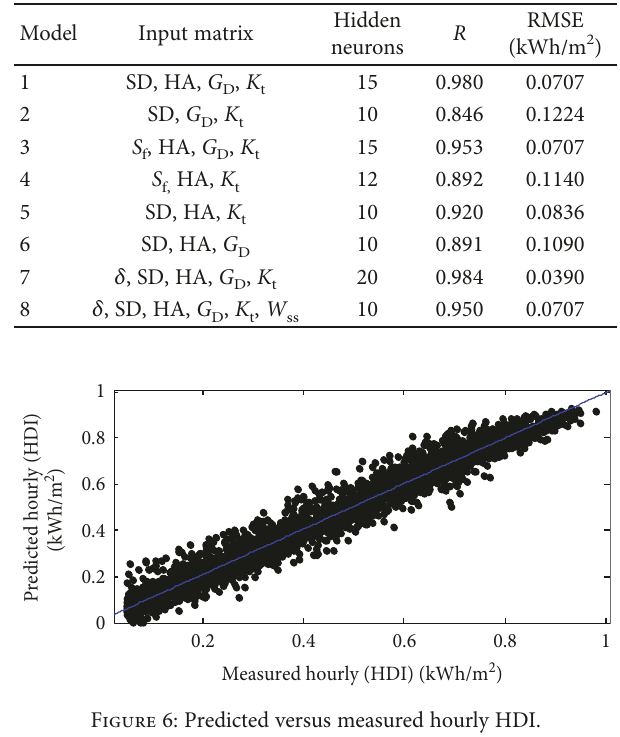
Table 3: Best performance of learning processes for di ff erent FFNN h con fi gurations.